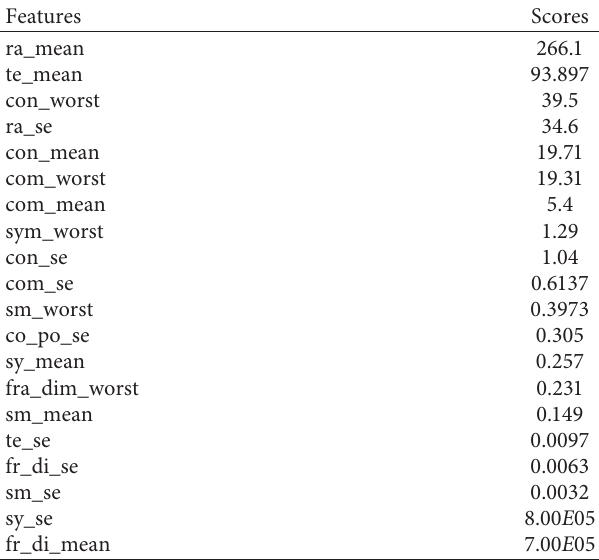
Figure 3: The ranking of all features which apply RFECV. Table 2: The score of all features which are selected by